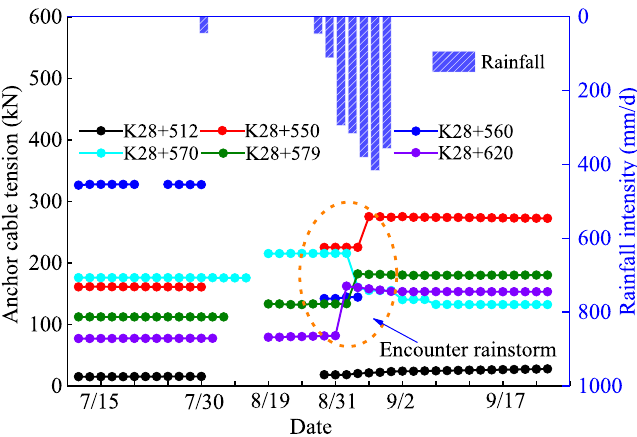
Figure 16. Changes of anchor cable tension at different positions before and after rainstorm.